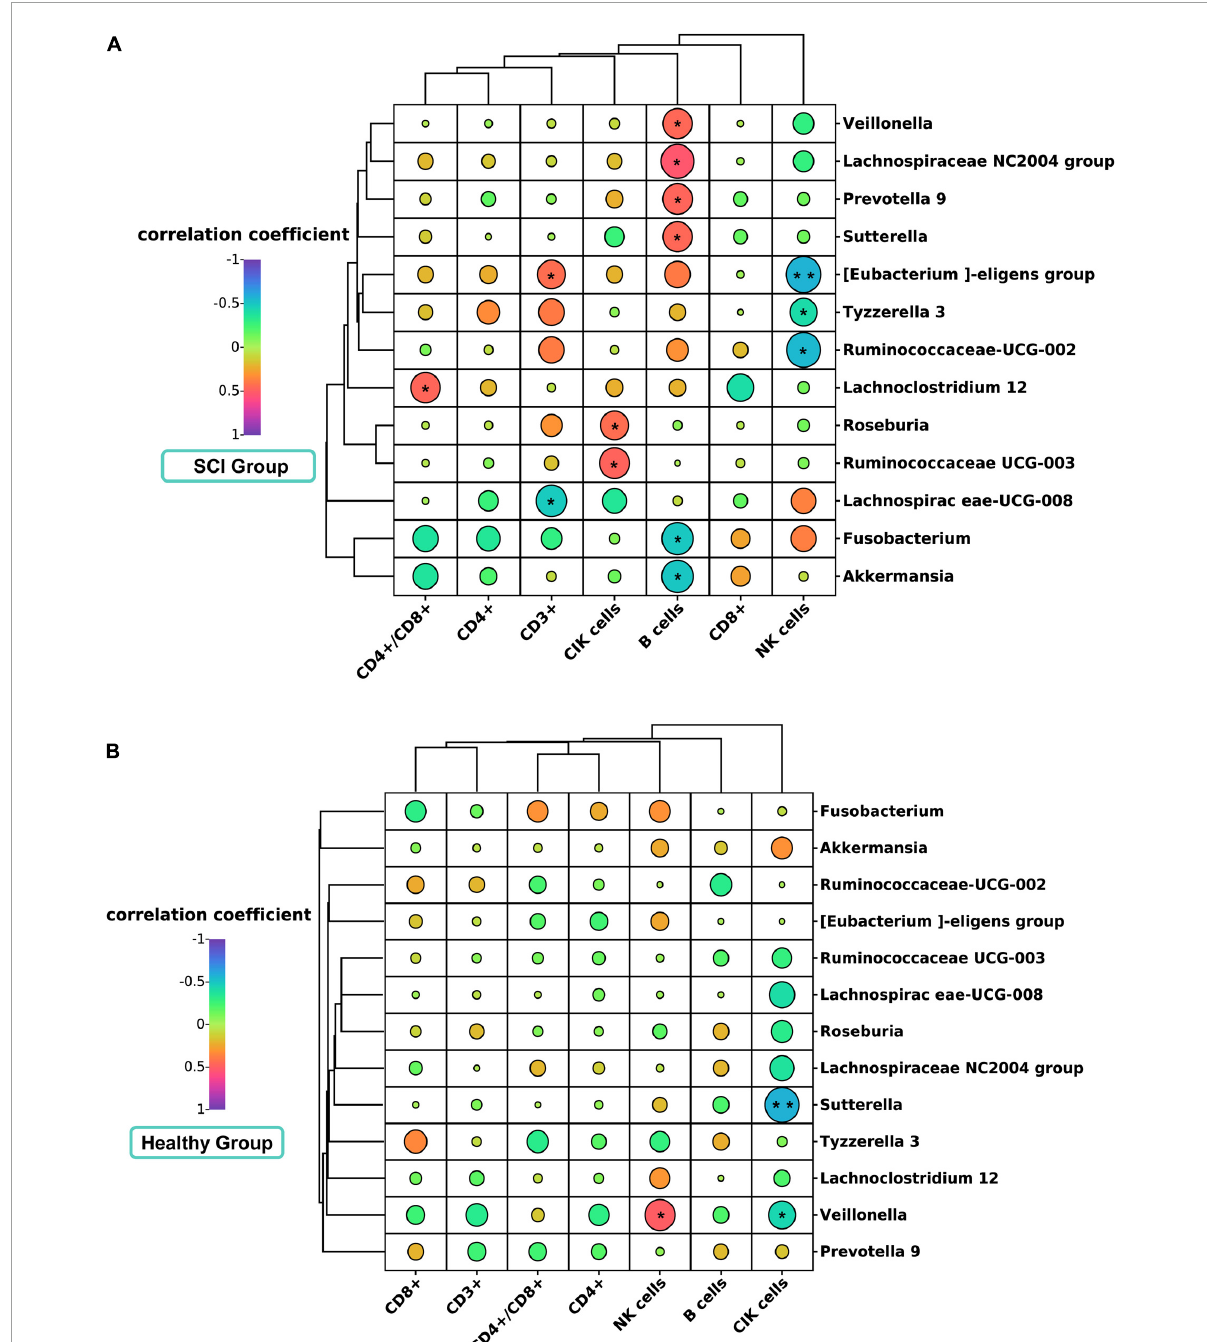
FIGURE7 Correlation analysis diagram of microbiota and lymphocyte subsets in SCI patients and healthy groups. Correlation between gut microbiota (genus level) and immune cell population in SCI patients (A) and healthy groups (B) . Spearman’s rank correlation coefficient is indicated using a color gradient: red indicates positive correlation and blue indicates negative correlation. * P < 0.05; ** P <